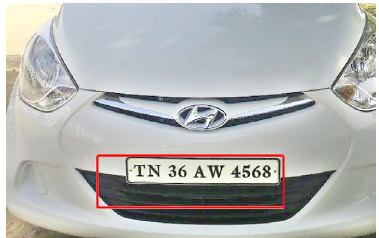
Figure 9. A stage of VEKIT license plate detection